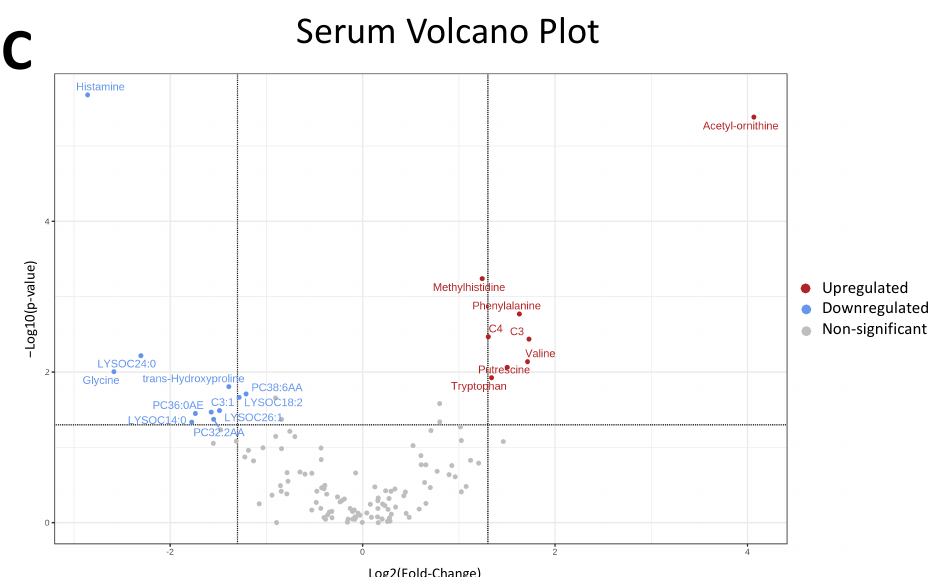
Figure 3. Volcano plots depicting the significant differences of metabolite concentrations in the urine ( A ), saliva ( B ), and serum ( C ) of HRP pigs in comparison to INF pigs. Each dot represents a metabolite. Red metabolites indicate an upregulation of the metabolite in HRP sows in comparison to INF sows, blue metabolites indicate a downregulation of the metabolite in HRP sows in comparison to INF sows, and grey metabolites indicate no change between HRP and INF sows. Fold-Change threshold = 2, p -value threshold = 0.05. A full list of p -values and FC values can be found in Supplementary Tables